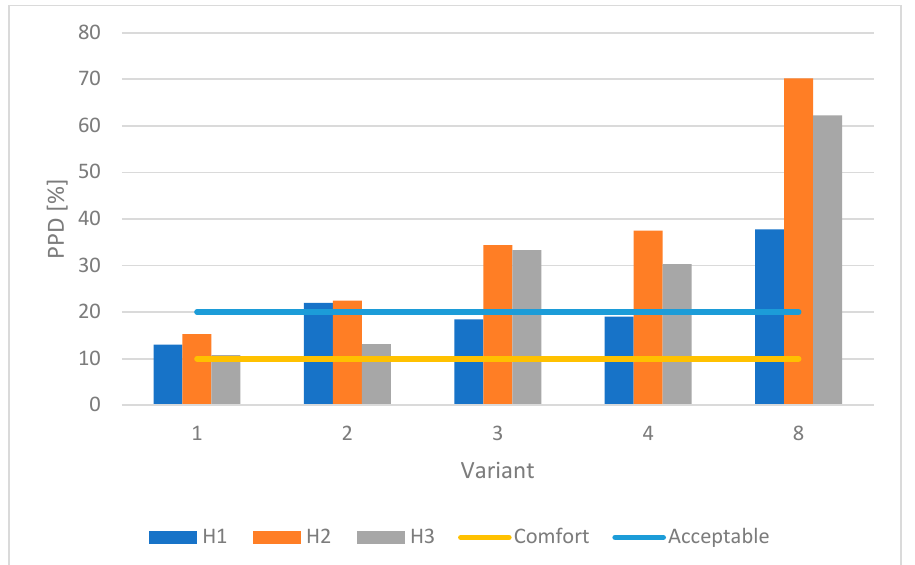
Figure 11. Comparison of PPD indexes for variant 1 to 5.